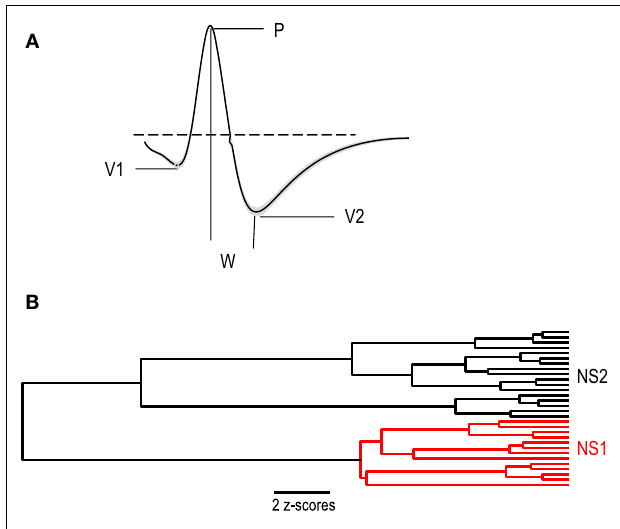
FIGURE 2 | Physiological classifi cation of narrow-spiking interneurons. (A) Spike shape features extracted from an average spike waveform: Peak (P), Width (W), pre-peak valley (V1), post-peak valley (V2). (B) Dendrogram depicting the clustering of narrow-spiking cells based on physiological similarities and differences. Two main clusters are evident: a relatively homogeneous cell population of narrow-spike type 1 cells (NS1; red) and a more heterogeneous cluster of narrow-spike type 2 cells (NS2; black). Scale bar indicates Euclidean distance between sub-groups.